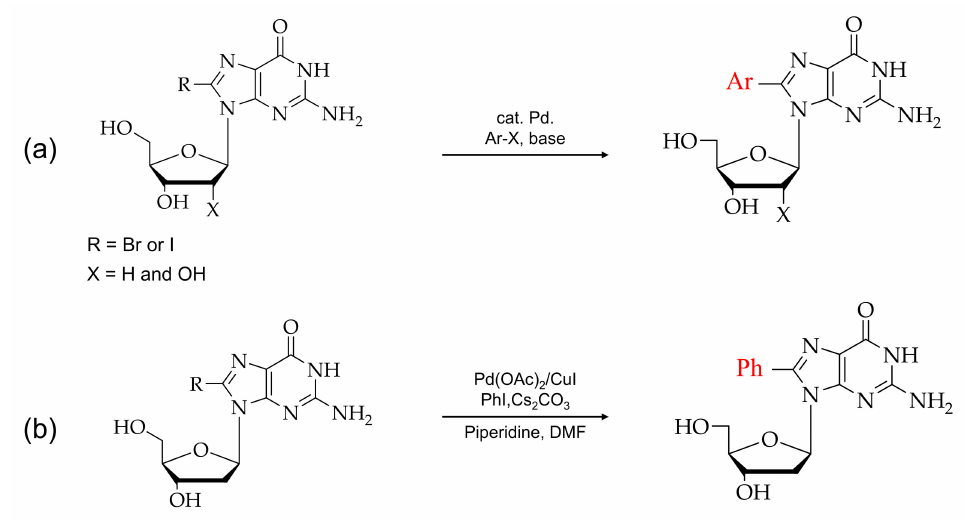
Figure 4. ( a ) Typical synthesis of 8-arylated guanosine. ( b ) Scheme for direct arylated guanosine derivatives at the C8 position.